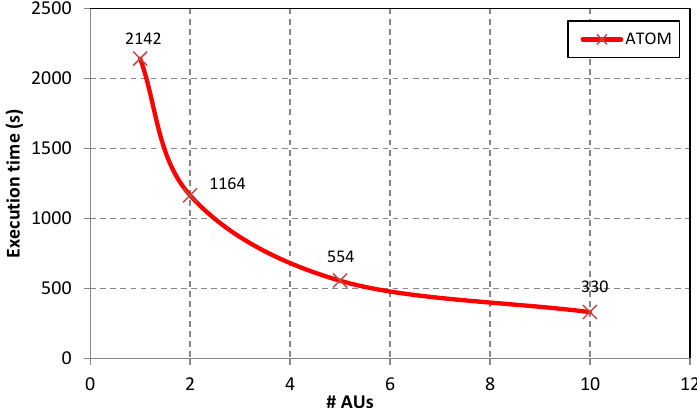
Figure 7. Execution time when extracting data from the ATOM section of PDB files stored in 10 sequential files (data set DS2) for the varying number of allocation units